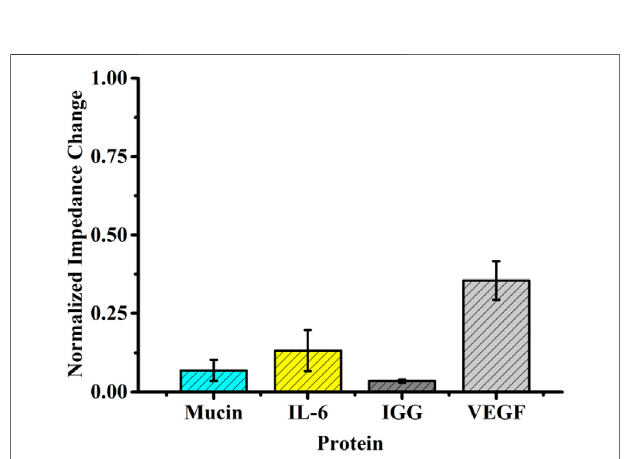
FIGURE 4 | EIS responses (A) and the corresponding calibration plot of normalized impedance (B) vs. log VEGF in 0.1 M KCl solution containing 5.0 mM [Fe(CN) 6 ] 3 − /4 − . Error bars, SD, n = 3.